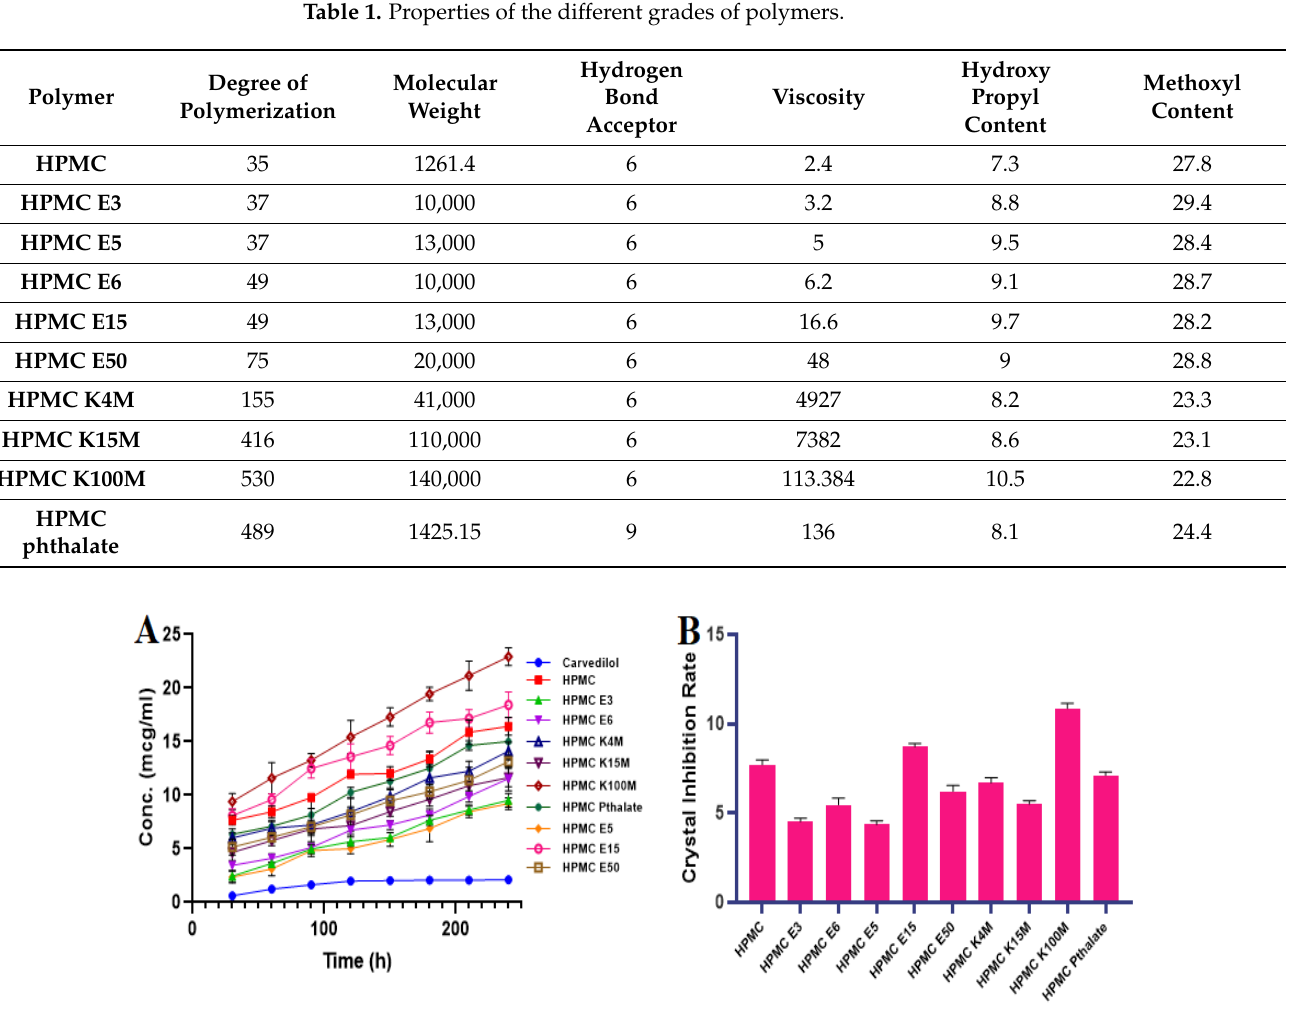
Figure 1. ( A ) The inhibition effect and ( B ) the crystal growth inhibition rate of the different grades of cellulose polymer.